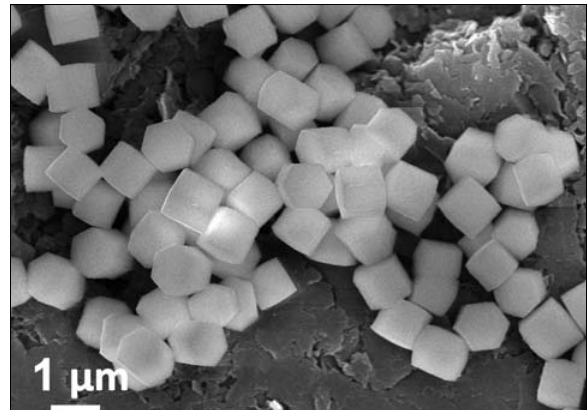
Fig. 4: SEM image of A-HT